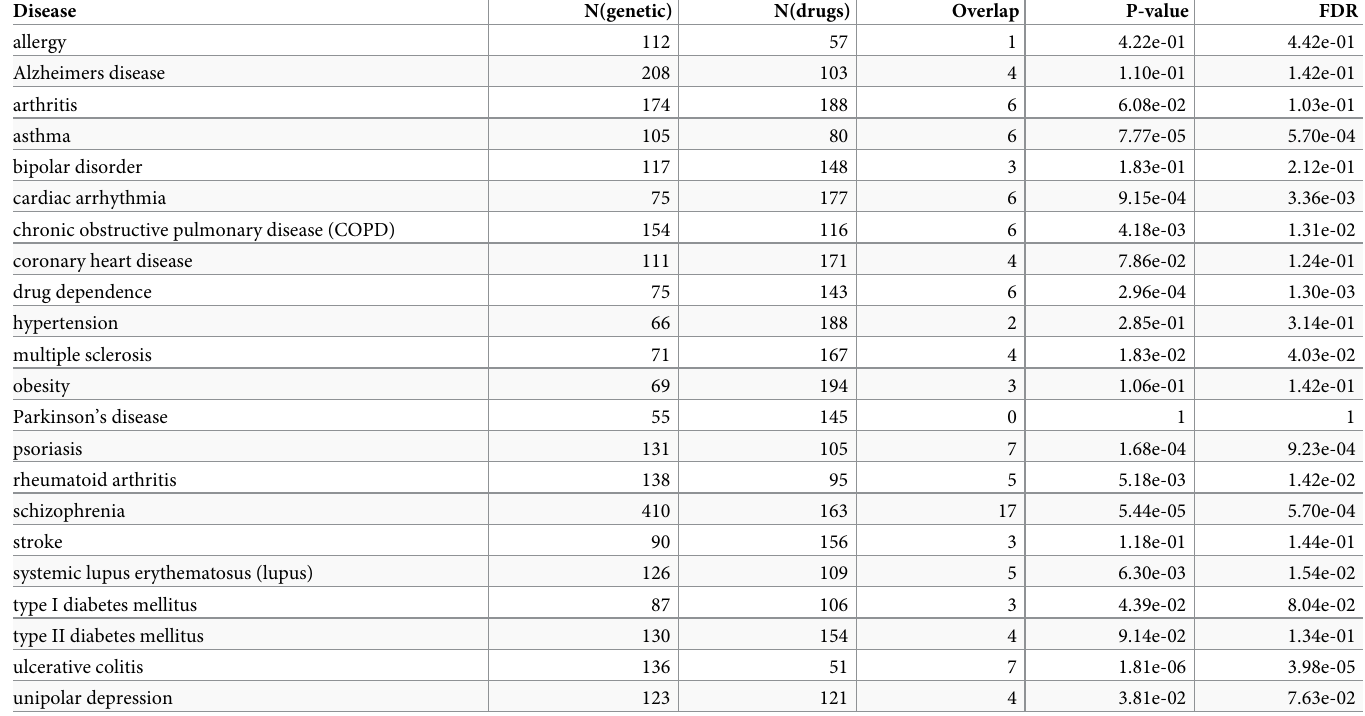
Table 2. List of diseases included in this